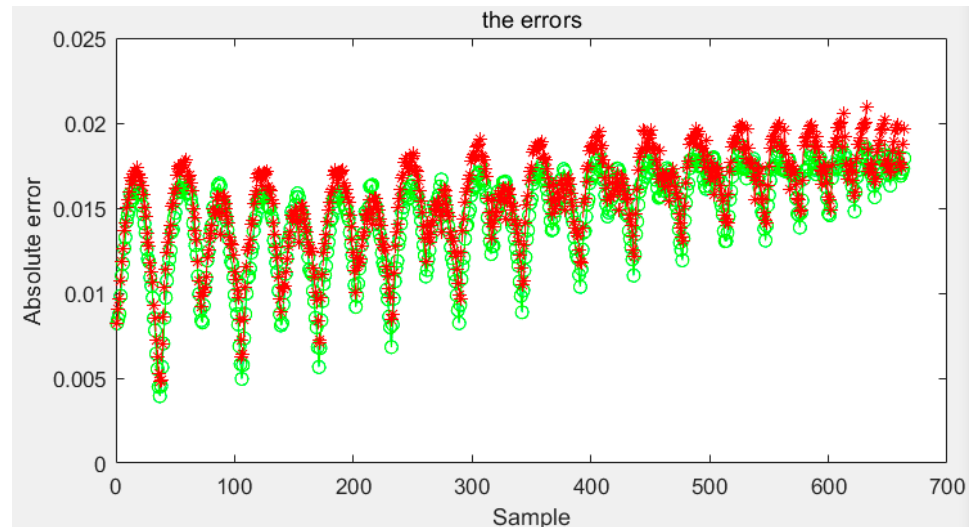
Figure 14. Test results of the second kind sensor.